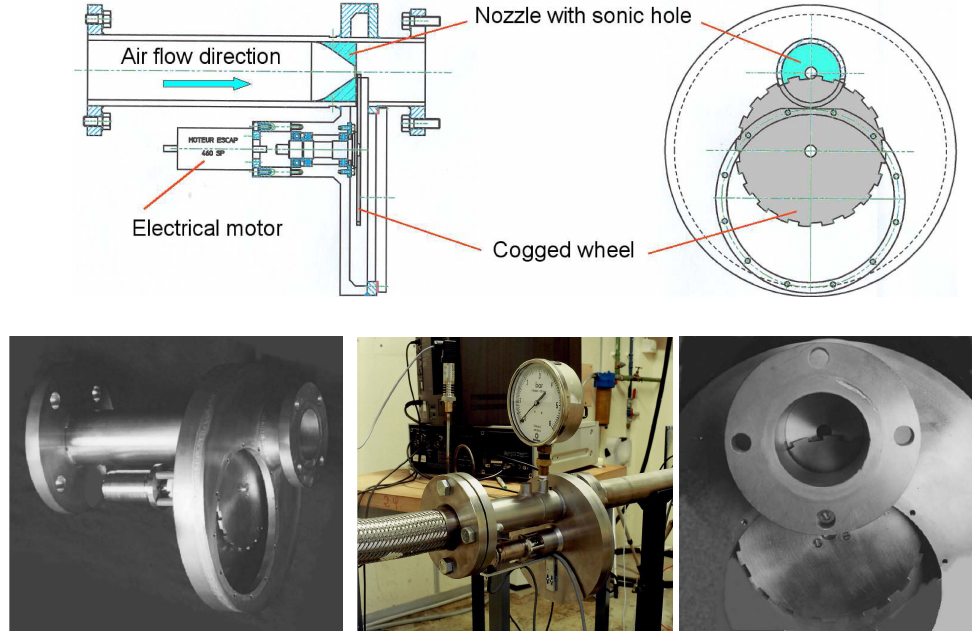
Figure 2. The ONERA siren [6,19,27]. ( Up ): Side and front views of the actuator. ( Down ): Views including open wheel